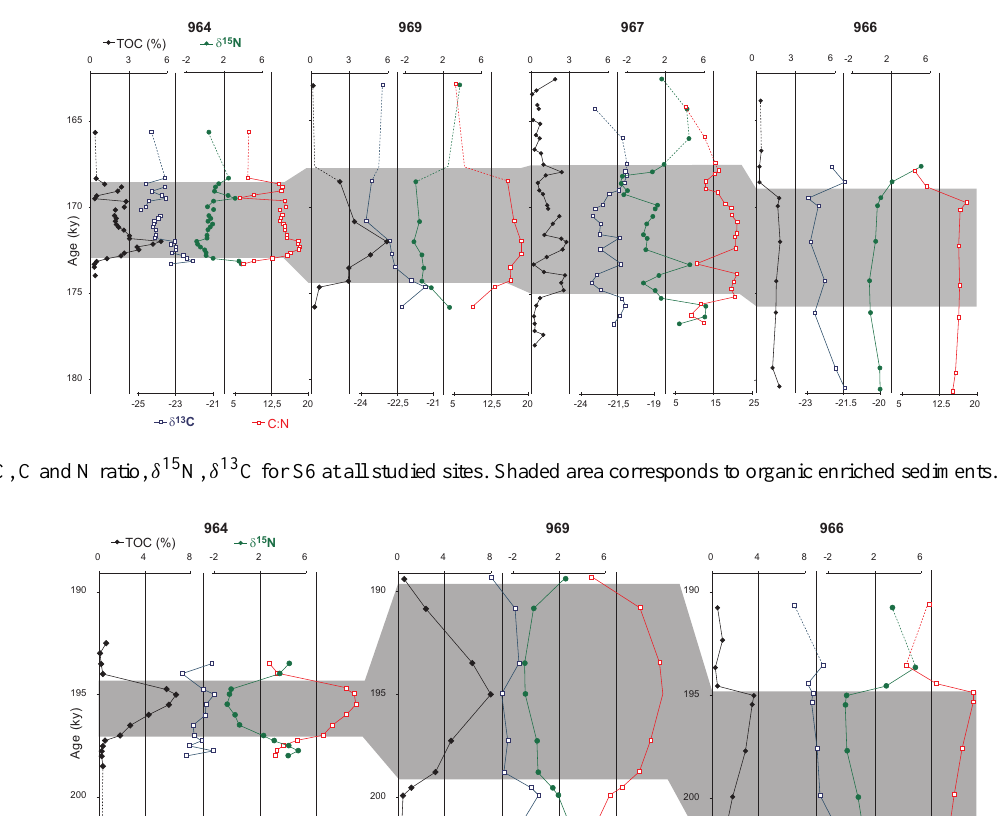
4.1.4 Paleoproductivity patterns based on Ba and C org